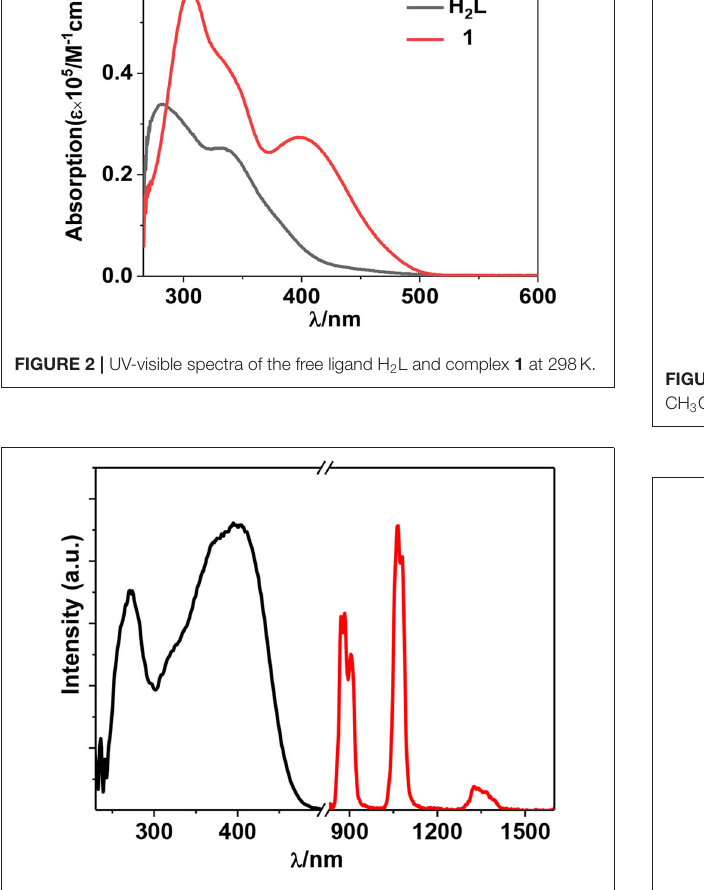
FIGURE 3 | Excitation ( λ em = 1,054nm) and emission ( λ ex = 395nm) spectra of 1 (50 µ M) in CH 3 CN at 298K.